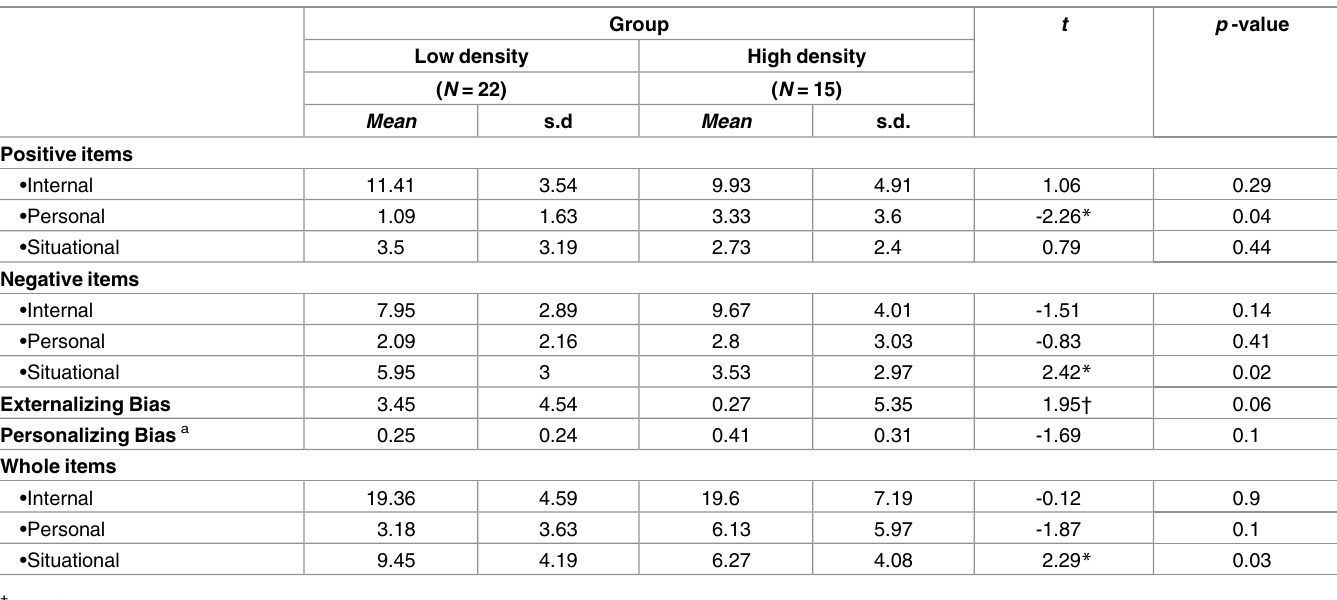
Table 2. Attribution style and network